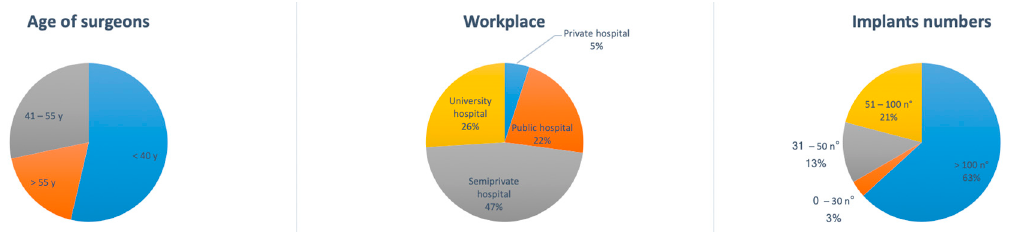
Figure 1. Demographic data, workplace and number of total annual implants. (y = year, n ◦ = number).